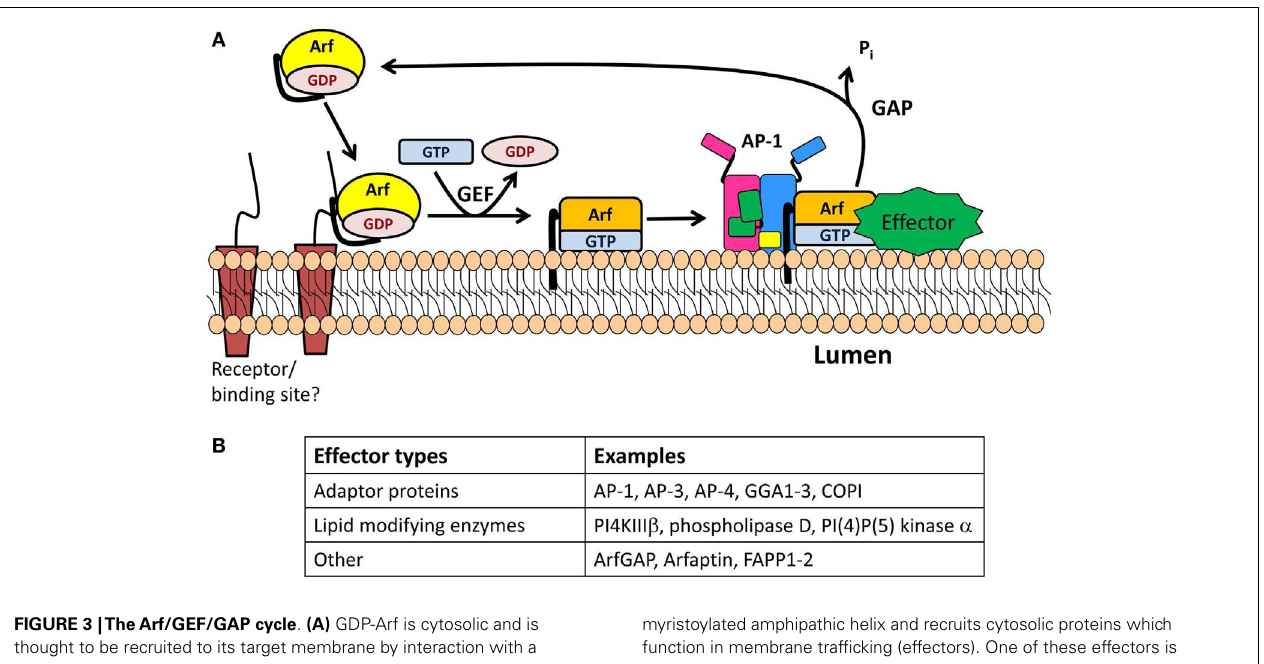
FIGURE 3 |TheArf/GEF/GAP cycle . (A) GDP-Arf is cytosolic and is thought to be recruited to its target membrane by interaction with a receptor.The exchange of Arf-bound GDP for GTP is catalyzed by an Arf-GEF, which induces a conformational change in Arf and release of GDP. GTP-bound Arf binds to the membrane through its N-terminal